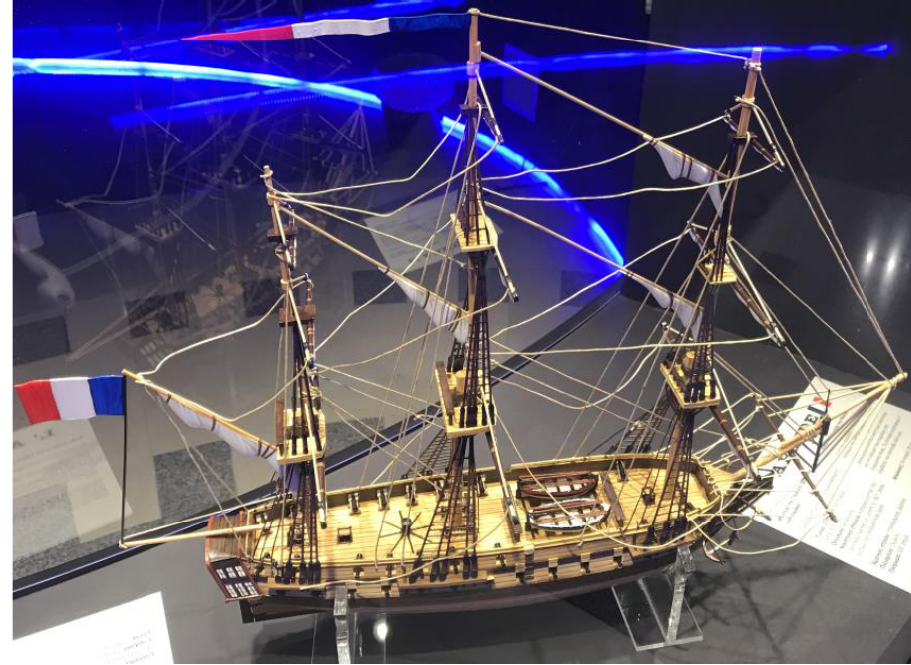
Figure 26 . Armide 3D-printed model after painting process. Figure 26. Armide 3D-printed model after painting